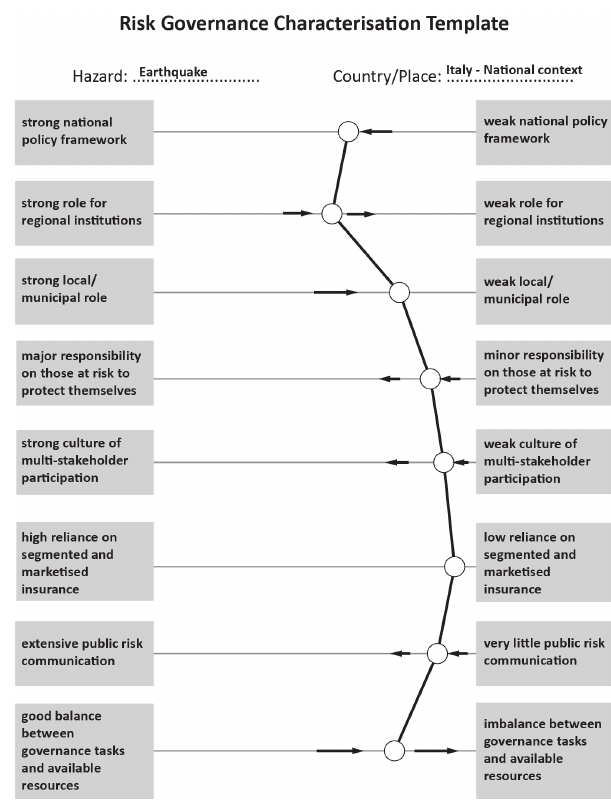
Fig. 5. Example of risk governance profile – Earthquakes in